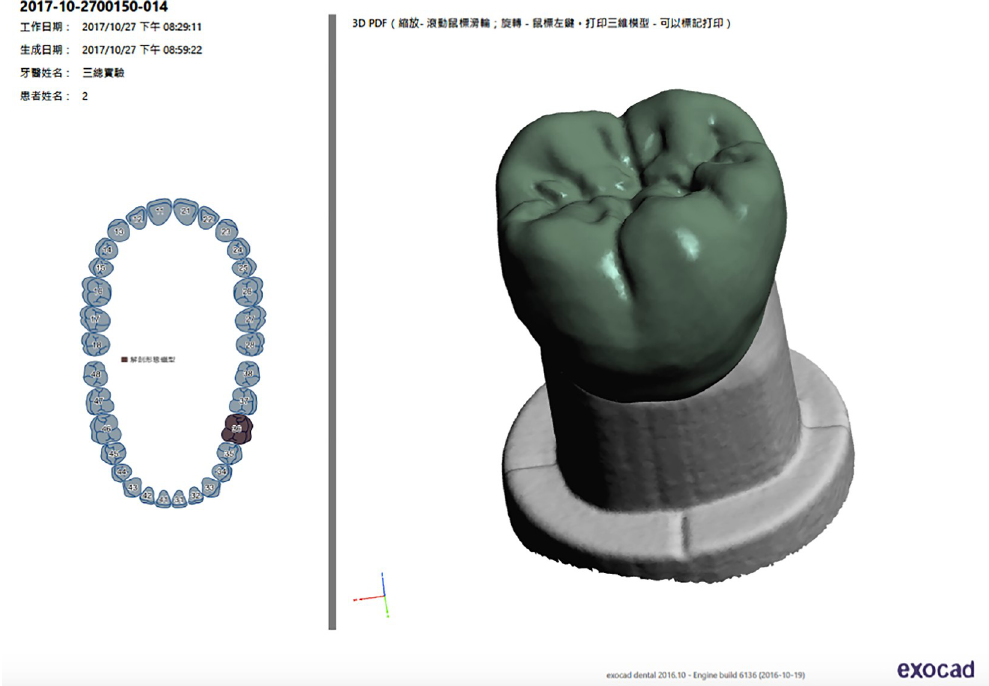
Fig 2. Computerized copy of the wax